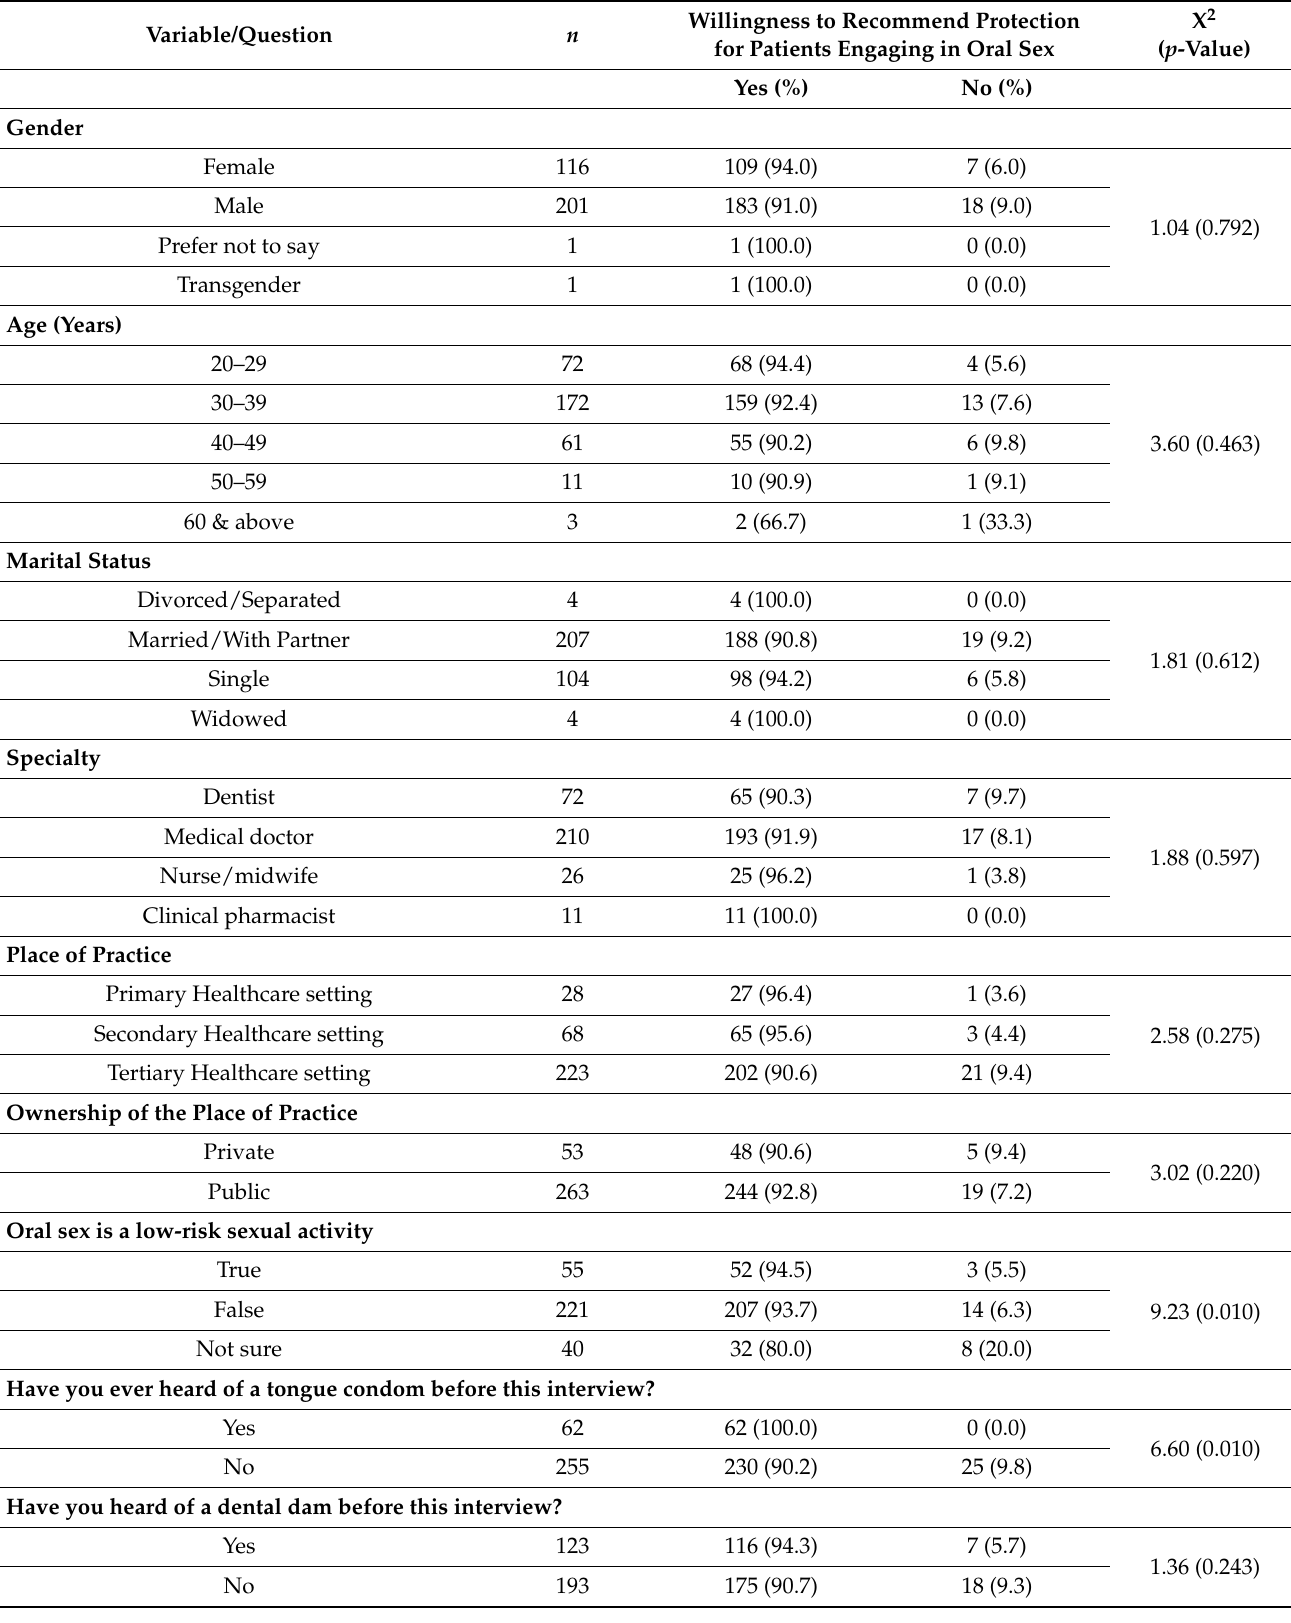
Table 6. Relationship between the respondents’ background characteristics, oral sex awareness, knowledge, and willingness to recommend protection for patients engaging in oral